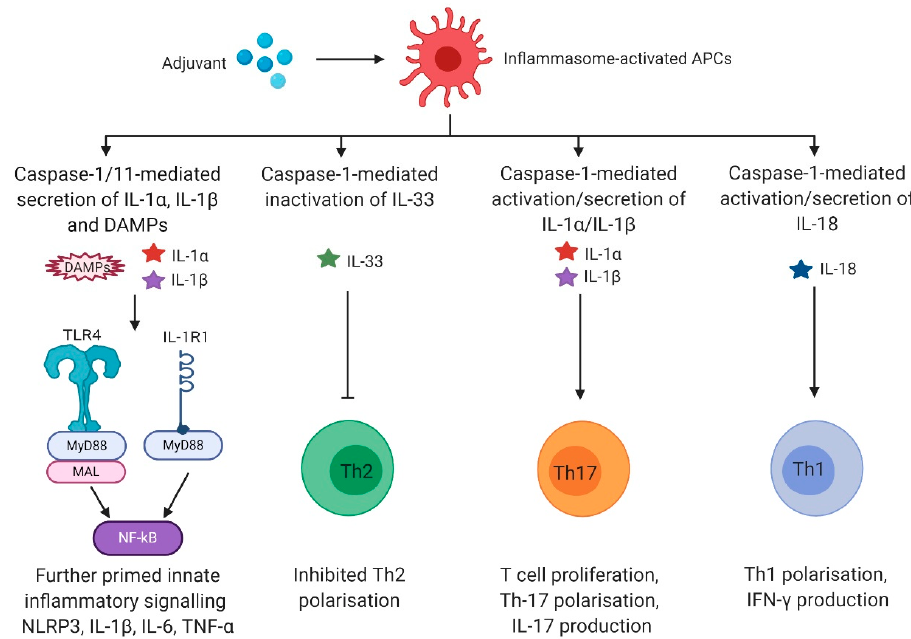
Figure 2. Caspase-1-dependent cytokines activate adaptive immunity. IL-1 α and IL-1 β signalling via IL-1R1 activates the pro-inflammatory transcription factor NF κ B via the MyD88 pathway. In